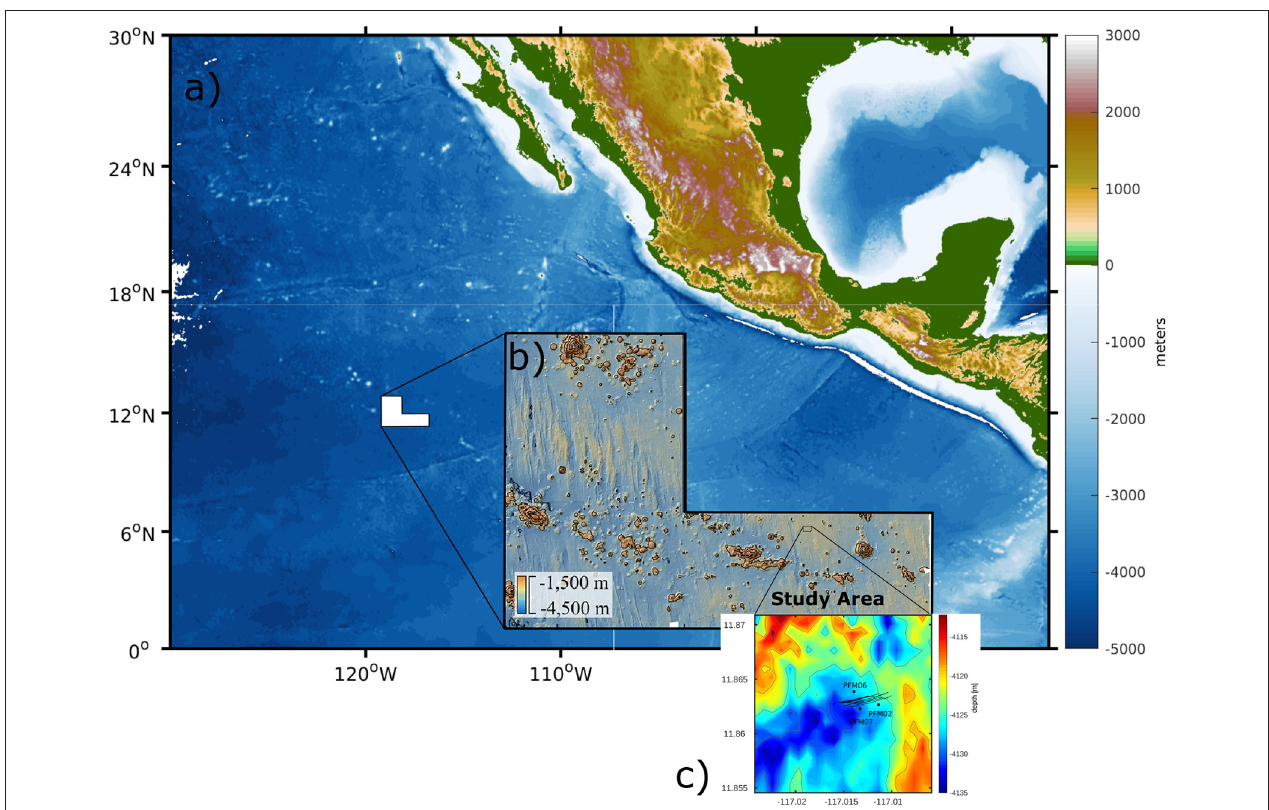
FIGURE 1 | (a) Location of the eastern German license area (GLA) in the northeastern Pacific Ocean. (b) Sea-floor topography of the eastern GLA. The black square in (b) depicts the dredging area (DA). (c) A zooming toward the DA used for the numerical simulation, with 5 m depth contours. The dredging tracks are shown as black lines. PFM02, PFM07, and PFM06 represent the locations of bottom-moored sensors for SSC and near-bed current